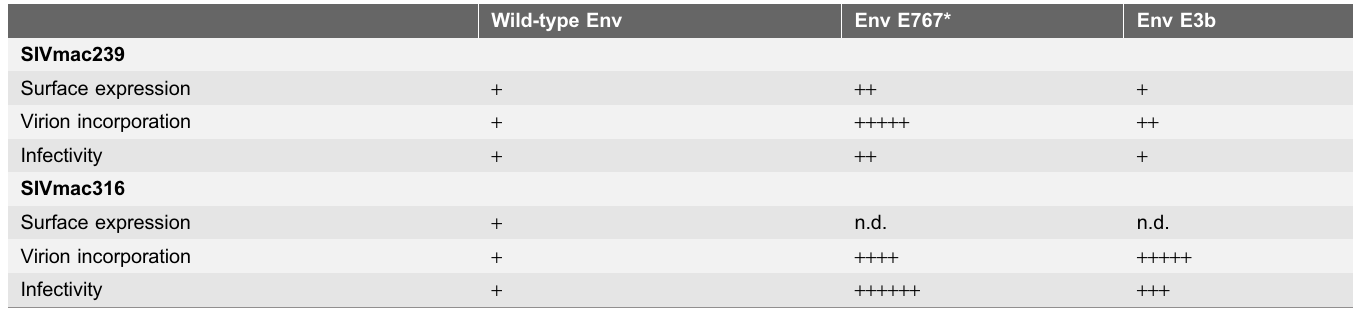
Table 2. Comparison of Env239 and Env316